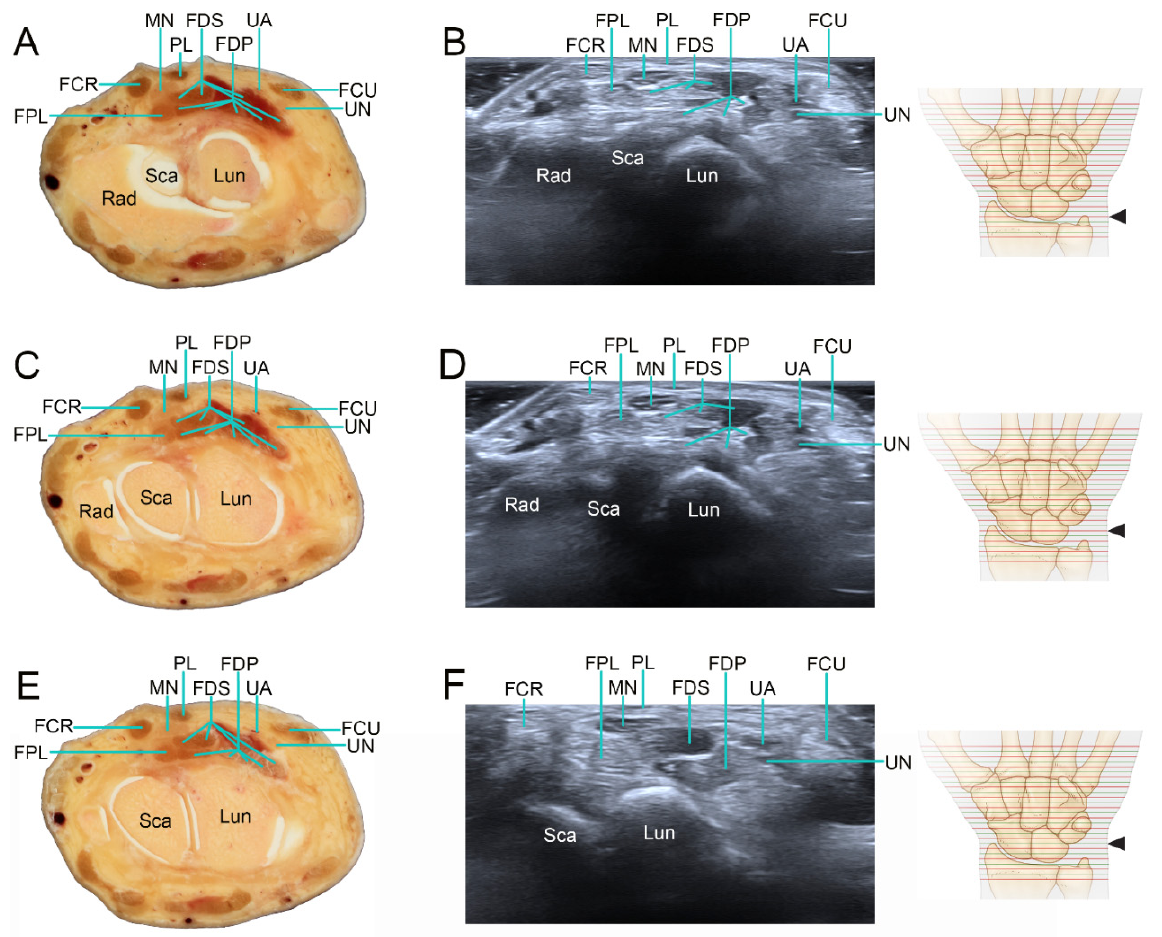
Figure 3. Sectioned images ( A , C , E ) and the corresponding US ( B , D , F ) images for transverse views at the radiocarpal joint . ( A , B ) The Rad contacts the scaphoid (Sca) and lunate (Lun) at the radiocarpal joint. The MN slightly moved along the second FDS tendon ( A ), and the MN is on the second and third FDS tendons ( B ). The UA is just radial to the FCU tendon, and the UN is deep to the FCU tendon. ( C , D ) At a more-distal level, the Sca and Lun become larger than at their former proximal level. The anterior border of the Lun becomes sharp and triangular in shape. The UA and UN gradually move toward the radial side, the UA is just radial to the FCU tendon, and the UN is deep to the FCU tendon. ( E , F ) At an even more-distal level, the anterior border of the Lun has a smooth convex shape. The amount of muscle fibers in the FDS and FDP decreased. The PL, FCR, and FCU tendons have constant sites and sizes. The UA is just radial to the FCU tendon, and the UN is deep to the radial side of the FCU tendon. Arrowheads in the schematics indicate the levels of the wrist scanned by the US